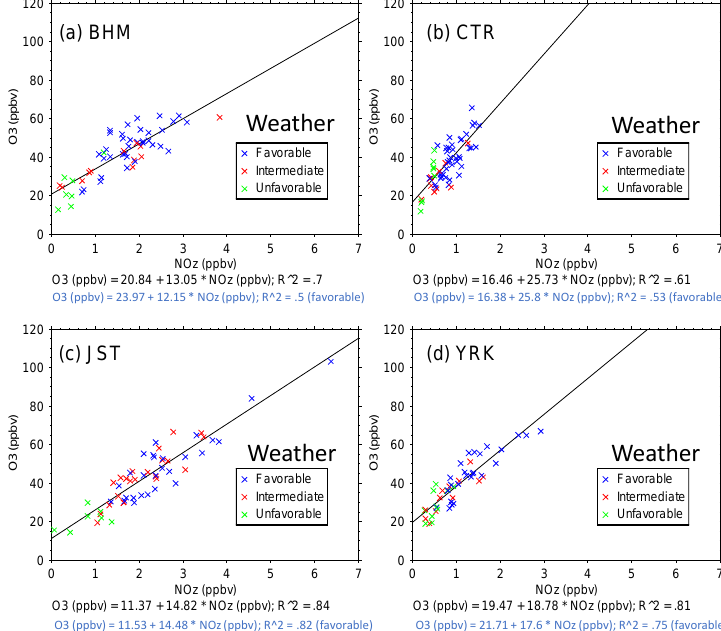
Figure 9. O 3 vs. NO z during June and July 2013. Each point is the 14:00–15:00 hourly average on 1 day. The data were selected to represent the approximate midpoint of the midday O 3 maxima and to span a period around the summer solstice ( ∼− 20, ∼+ 40 days) when solar radiation is highest on average. The regression slopes show higher rural than urban values: BHM = 13.05 ± 1.19ppbvppbv − 1 , JST = 14.82 ± 0.88ppbvppbv − 1 , YRK = 18.78 ± 1.38ppbvppbv − 1 , and CTR = 25.73 ± 2.76ppbvppbv − 1 . Corresponding regression slopes for O x vs. NO z are BHM = 12.00 ± 1.16ppbvppbv − 1 , JST = 13.88, ± 0.93ppbvppbv − 1 , YRK = 18.85 ± 1.37ppbvppbv − 1 , and CTR = 25.79 ± 2.79ppbvppbv − 1 . Symbols indicate the favorability of weather to O 3 formation and accumulation: (1) favorable – T > 25 ◦ C, RH < 70%, and solar radiation > 500Wm − 2 ; (2) intermediate – neither favorable nor unfavorable; (3) unfavorable – T < 25 ◦ C, RH > 70%, and solar radiation < 500Wm − 2 . Regression results are shown for all days and for the days with favorable